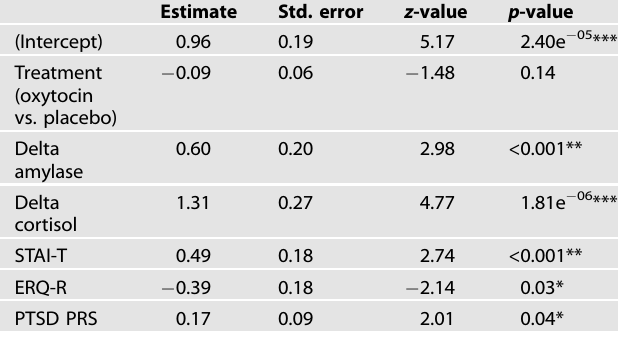
Table 2. Stepwise Poisson regression.